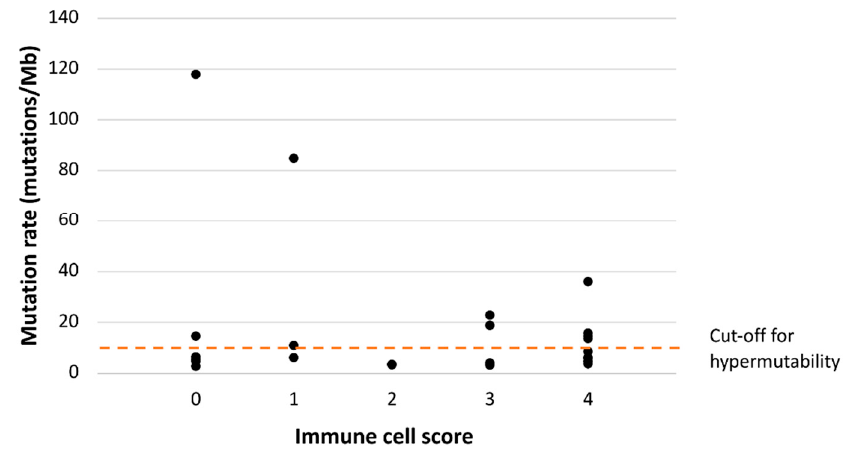
Figure 3. Somatic mutation rates plotted against ICS in CA-CRC. Somatic mutations consisted of somatic non-synonymous mutations with VarScan2 (Genome Institute, Washington University, St. Louis, MO, USA) p value < 0.05 (27 tumors sequenced in our previous study were included in this analysis).